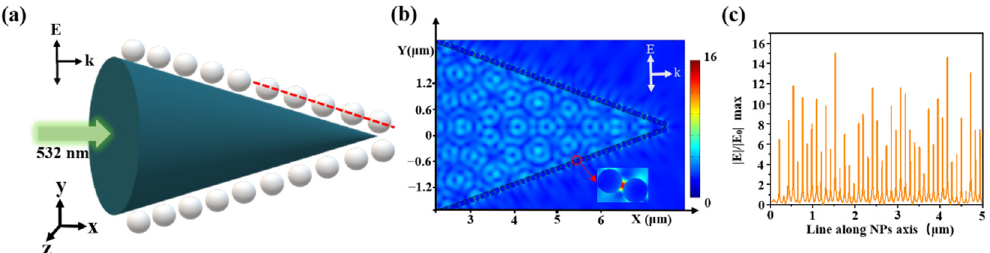
Figure 6. ( a ) Schematic diagram of the simulation model, an incident light of 532 nm, Ag diameter of 100 nm, gap of 10 nm; ( b ) spatial distribution of the electric field and ( c ) the corresponding electric-field values along a red line in ( a